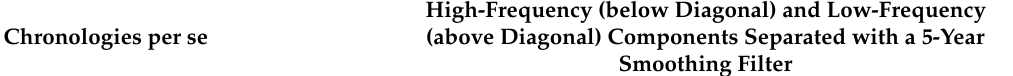
Table 2. Correlations between P. sibirica residual TRW chronologies over the 1936–2010 period of dendroclimatic